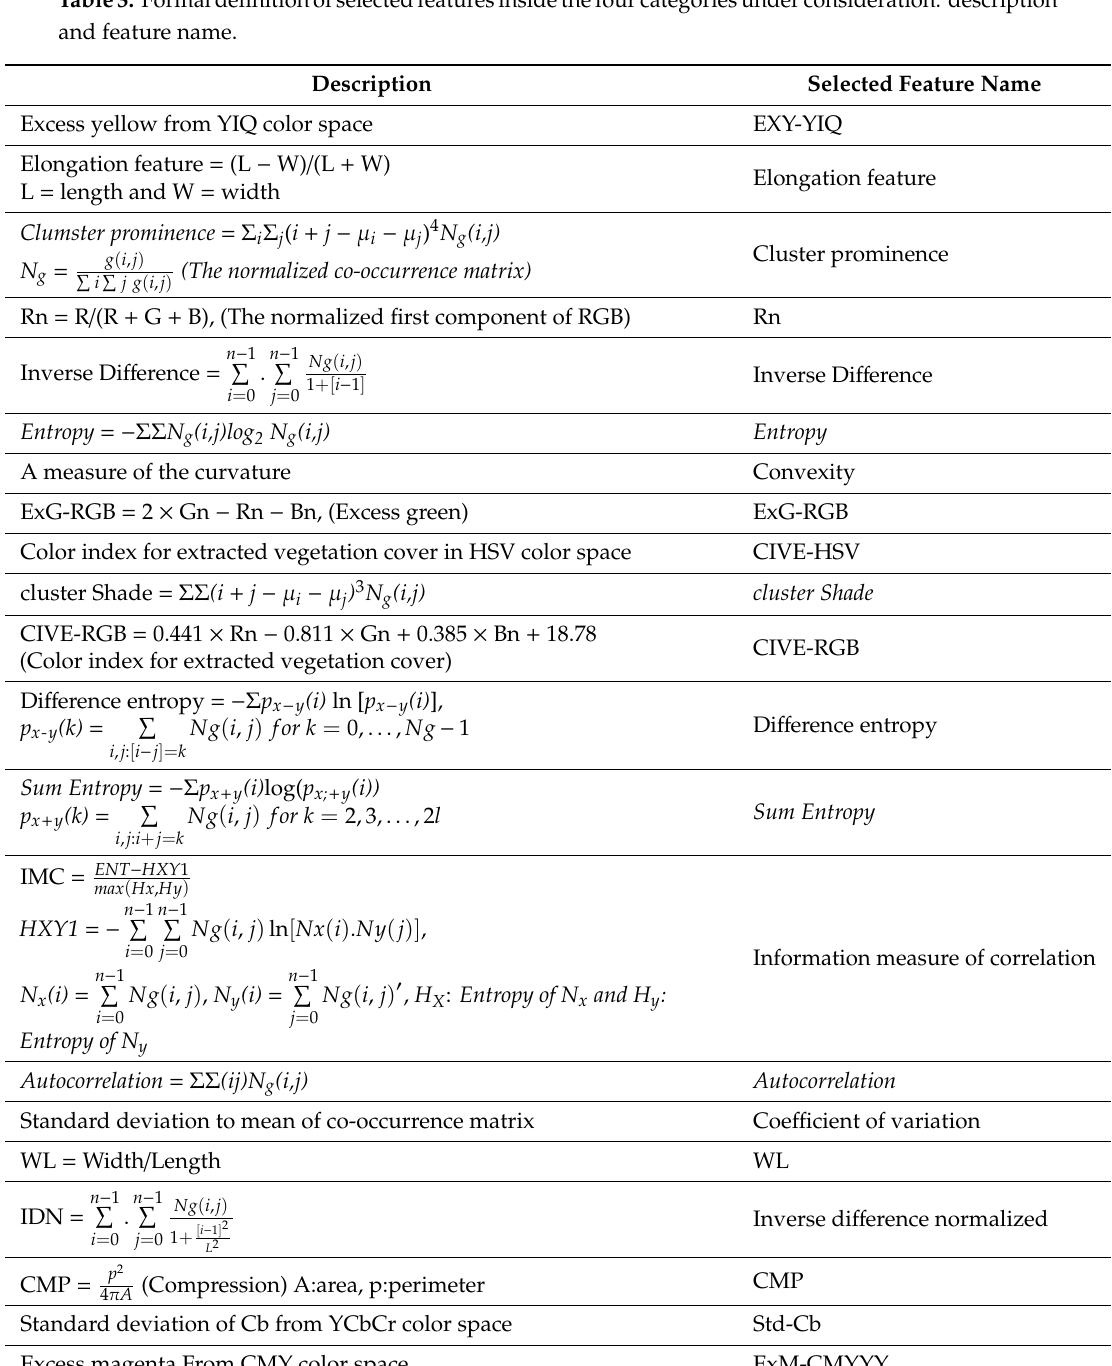
Table3. Formaldefinitionofselectedfeaturesinsidethefourcategoriesunderconsideration: description and feature